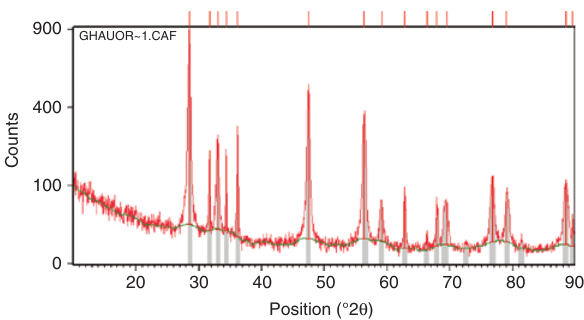
nanocomposite. 2